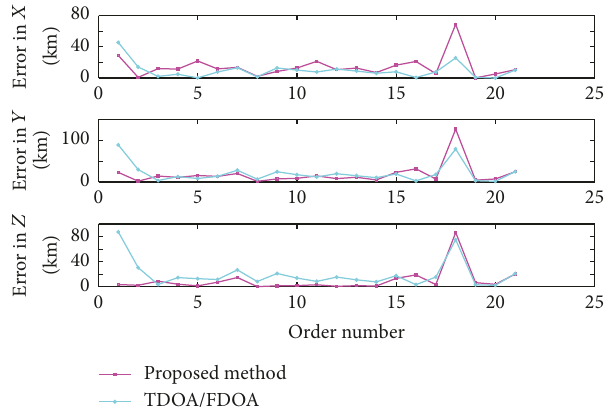
Figure 7: Positioning error in 𝑋 , 𝑌 , 𝑍 direction for records unavailability scenario.